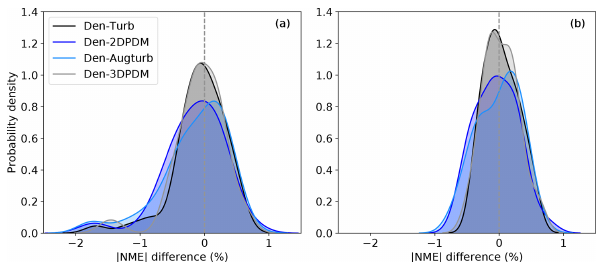
Figure C2. (a) Probability density distribution of overall differ- ences in absolute NMEs per file between the baseline method and the four trial methods: Den-Turb in black, Den-2DPDM in blue, Den-Augturb in light blue, and Den-3DPDM in grey; (b) as in (a) , but after filtering the 0.1 quantile of absolute NME differences. Negative data points mean the specific trial method yields an over- all absolute NME closer to zero than the baseline for those sub- missions, and data with positive values indicate that such a method results in larger overall absolute NMEs than the baseline. The grey dashed line in each panel marks the NME difference of